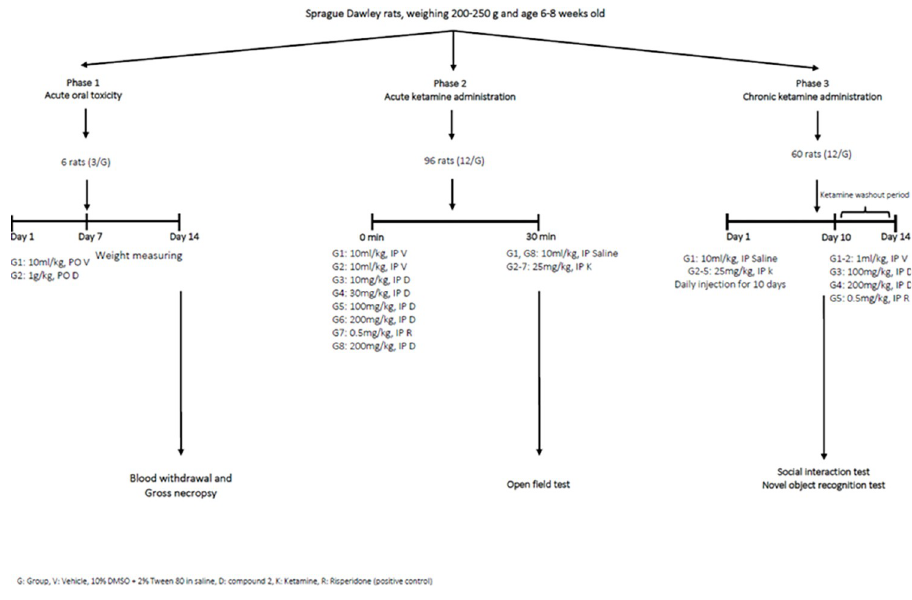
Fig 1. Flowchart of experimental